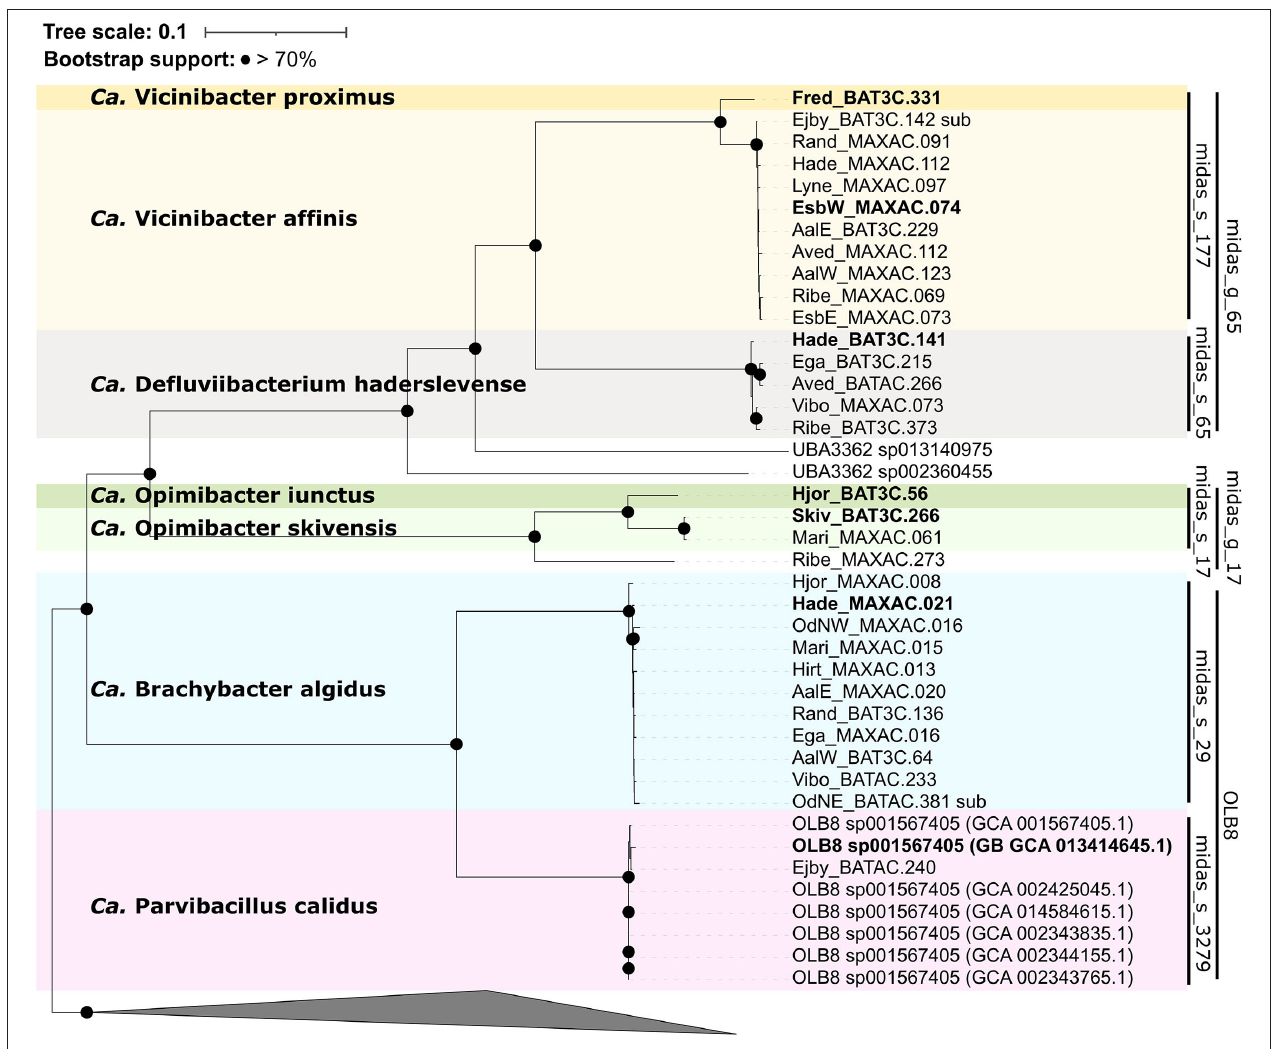
FIGURE 4 | Maximum likelihood genome tree created from the concatenated alignment of 120 single-copy marker gene proteins trimmed to 5,000 amino acids using the GTDB-Tk v1.5.0. Branches with bootstraps support > 70% are indicated by black dots. Species representatives are in bold. The genera Lewinella , Haliscomenobacter , and Saprospira were used as the